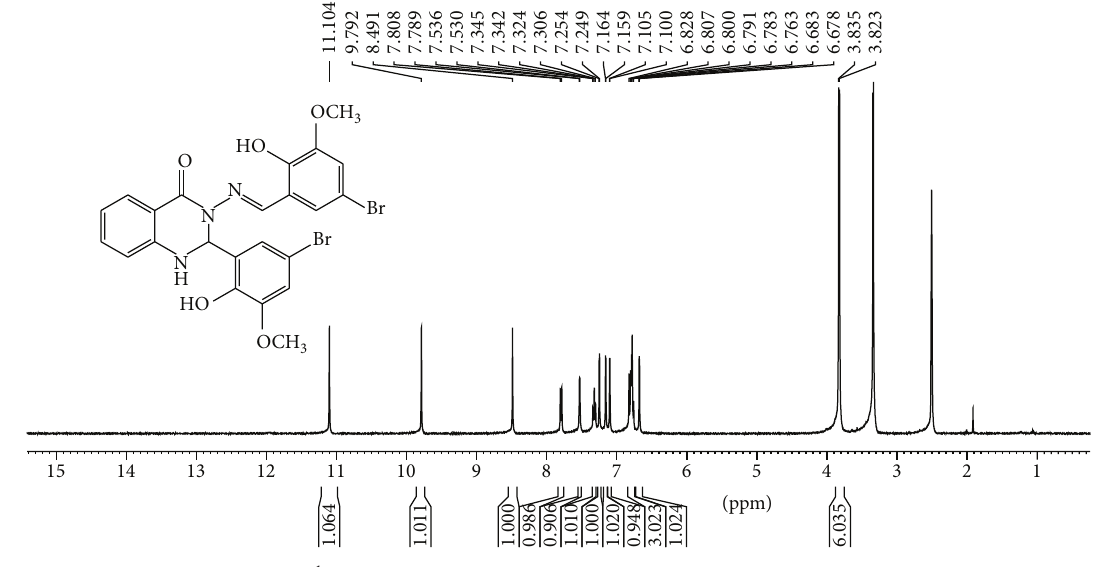
Figure 7: 1 H NMR spectrum of a compound (2) in (400 MHz, DMSO- d6 ).